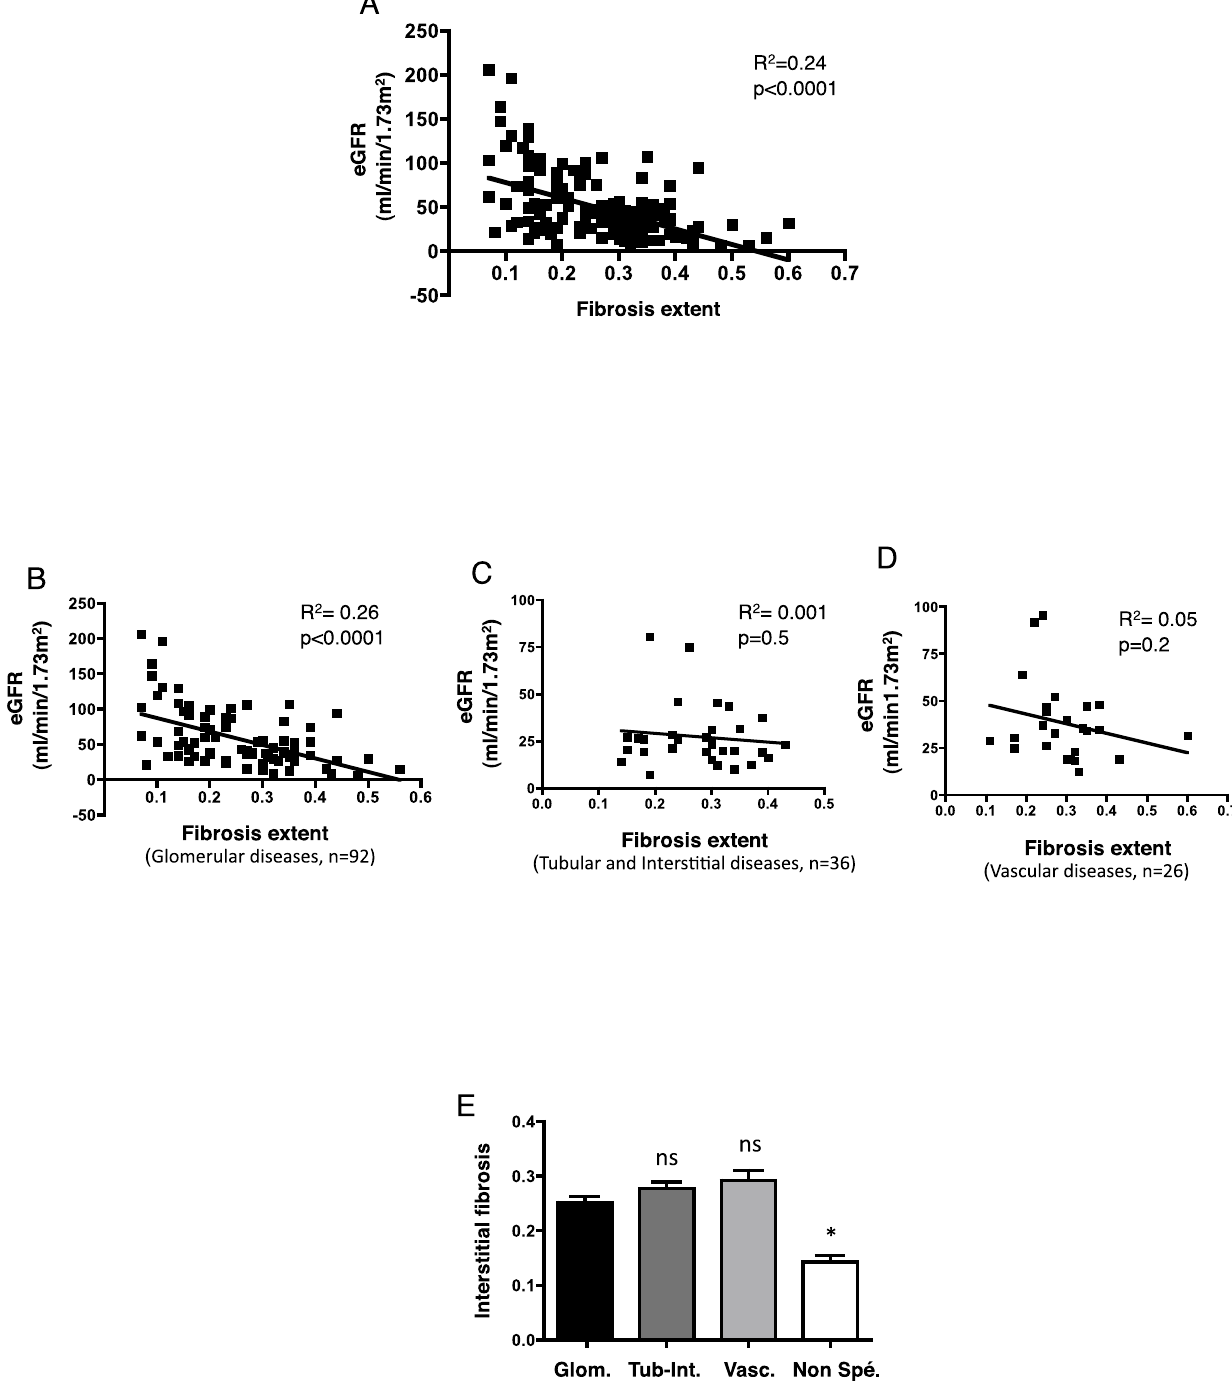
Figure 4. Correlation between the estimated glomerular filtration rate and extent of interstitial fibrosis. A . Best-fit slope of the linear regression between eGFR and extent of fibrosis. B , C , D . Best-fit slope of the linear regression between eGFR and extent of fibrosis in glomerular disease (B), tubular disease (C), and vascular disease (D). E . Histogram of the distribution of the extent of interstitial fibrosis according to the type of kidney disease. The percentages of interstitial fibrosis are expressed as the mean 6 sem. *p , 0.05 compared to glomerular disease, using Student’s T test; the Mann-Whitney test was used for the glomerular vs. non specific lesions comparison. Glom: glomerular diseases; Tub-Int: tubular and/or interstitial diseases; Vasc: vascular diseases; Non-spe: non-specific.